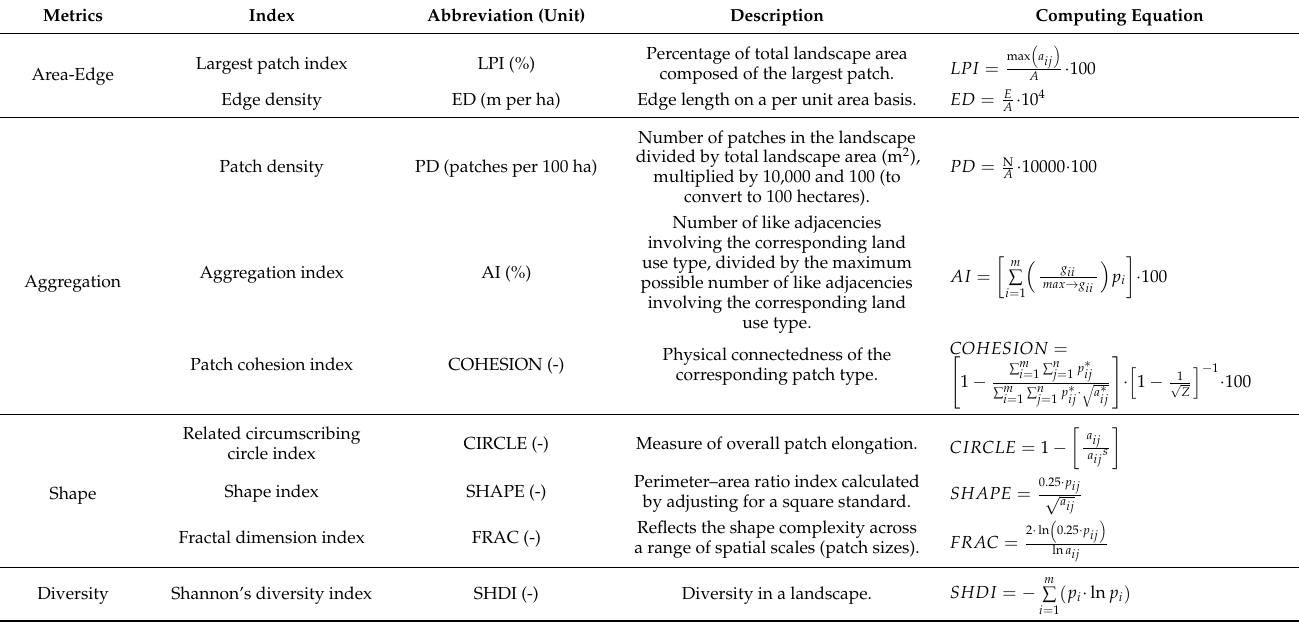
Table 3. Selected landscape metrics for quantifying landscape composition and configuration